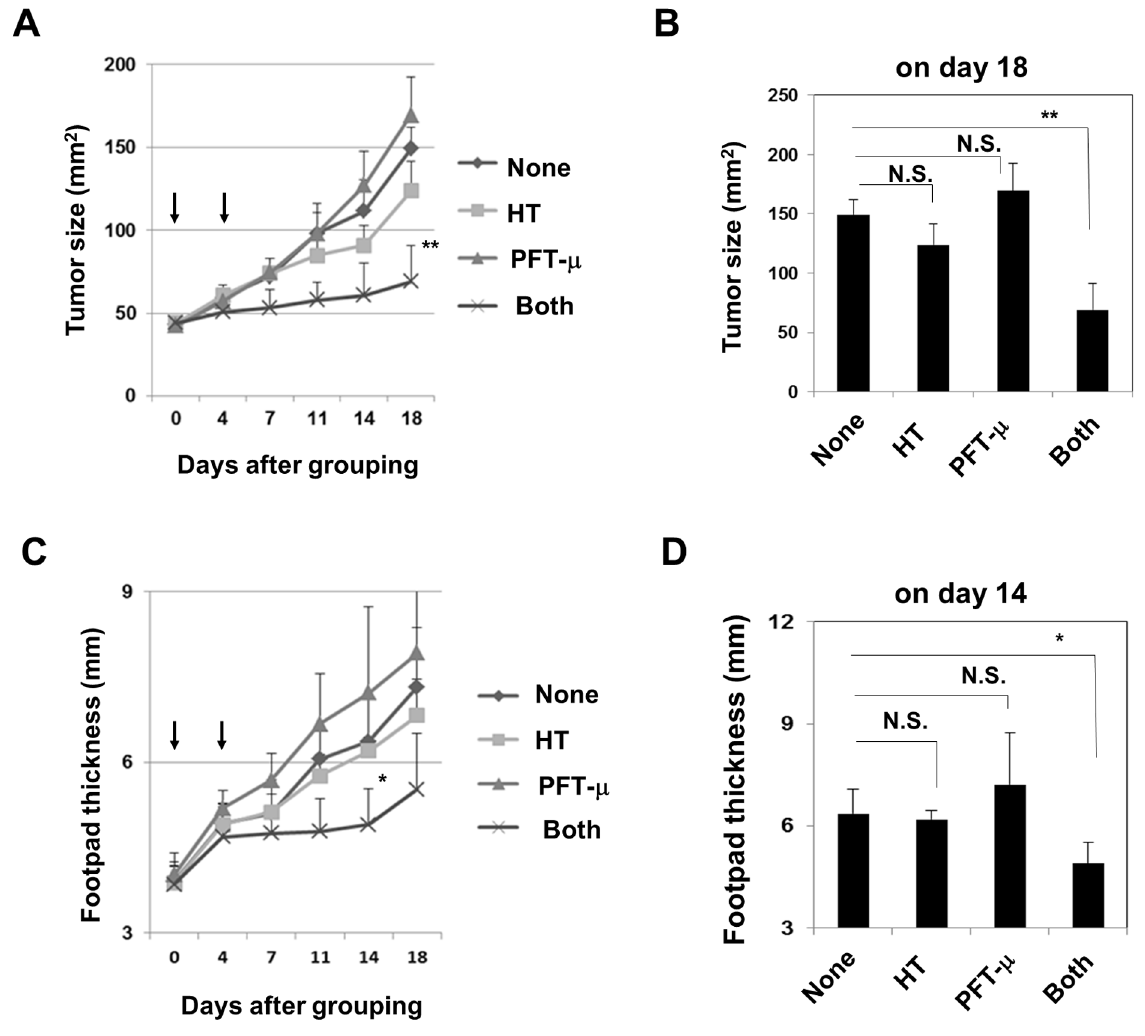
Figure 7. Invivo antitumor effects of PFT- m and HT in a xenograft mouse model. BALB nu/nu male mice were inoculated in the right footpad with 1 6 10 6 PC-3 cells with Matrigel. On day 15, the mice were pooled and divided into four groups. Each group contained six mice. On days 0 and 4 after grouping, the PC-3-bearing mice were locally injected with PFT- m (100 m g in 50 m l) and/or treated with HT (43 u C for 30 min). Arrows represent the day of treatment. As a vehicle control, 50 m l of DMSO were injected. HT was performed 1 h after the local injection of PFT- m . Thereafter, the tumor size, the product of two perpendicular diameters ( A, B ), and the footpad thickness ( C, D ) were measured twice weekly. The results are shown as the mean 6 SD of six mice. * P , 0.05 ** P , 0.01 (Dunnett test) N.S., not